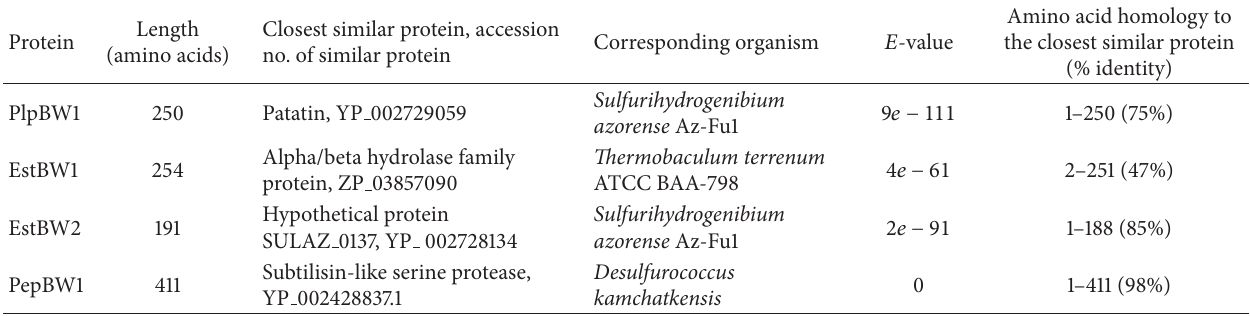
Table 3: Novel lipolytic and proteolytic enzymes and their closest relatives in the NCBI database.